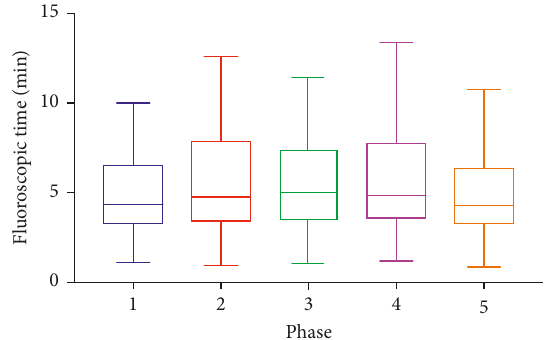
Figure 1: Median reference air kerma values during the different phases of the study. The error bars represent first and third quartile values.